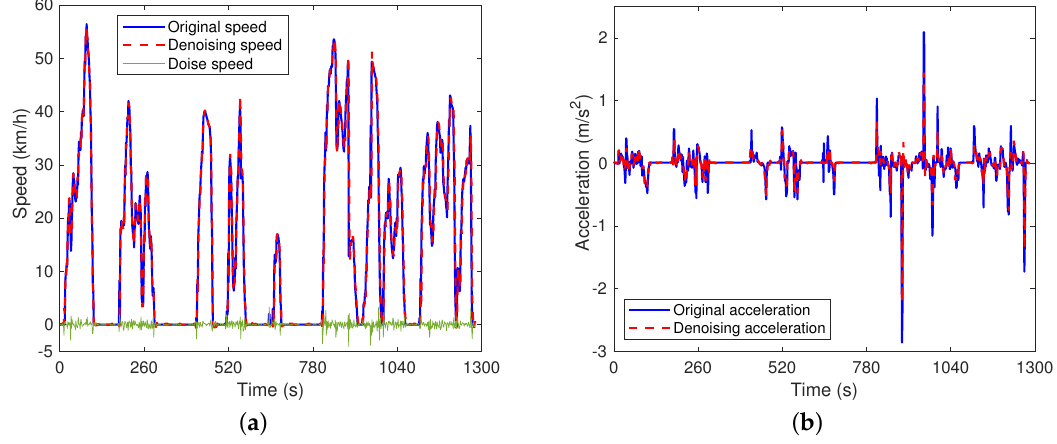
Figure 2. Original and wavelet-denoised driving characteristics: ( a ) original and denoising speed signal and speed noise. ( b ) Original and denoising acceleration